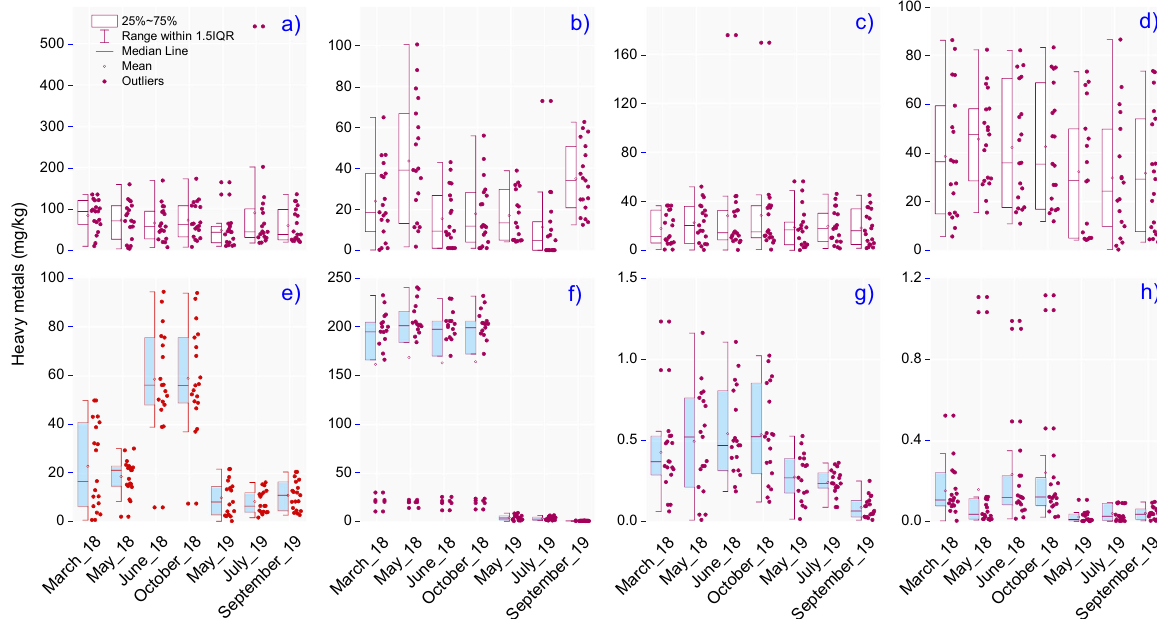
Fig. 3 Distribution of heavy metal sediment content collected during seven periods in 2018 − 2019 and 19 sites along middle and lower Olt River riches. a Zn, b Cr, c Cu, d Ni, e Pb, f As, g Cd, h Hg. ZnCrCuNiPbAsCdHg